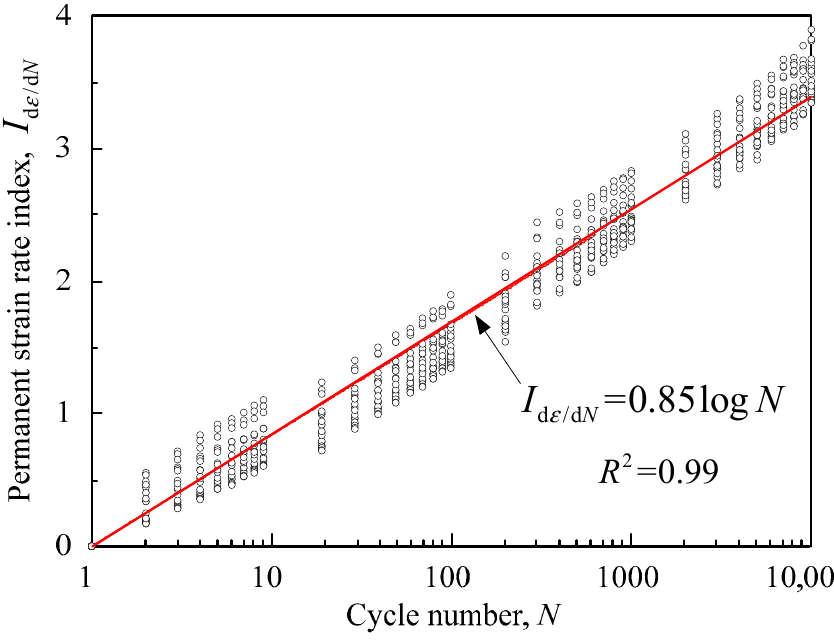
Figure A1. Linear regression analysis on the relationship between I d ε /d N and N for the tested samples.